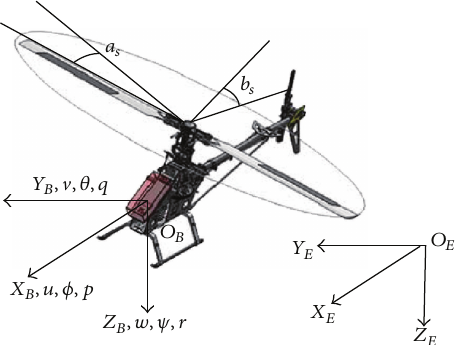
Figure 1: TREX 600 states in body-fixed coordinate frame